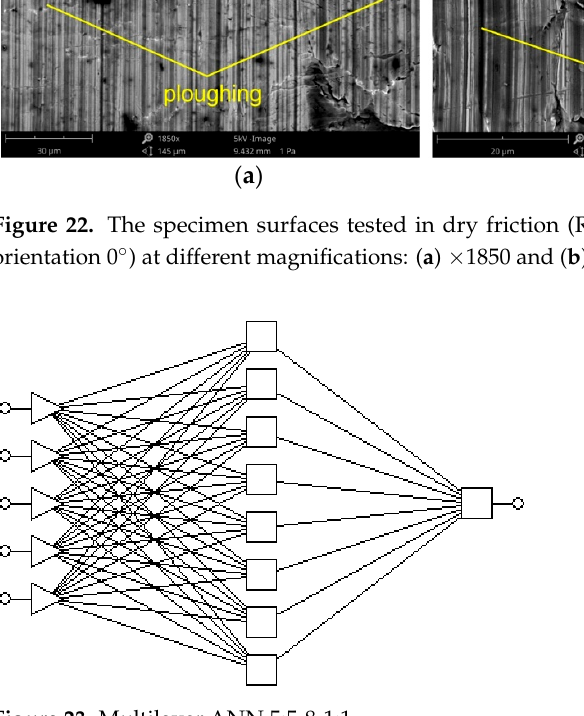
Table 3. Values of RMS error for training (T) and validation (V)